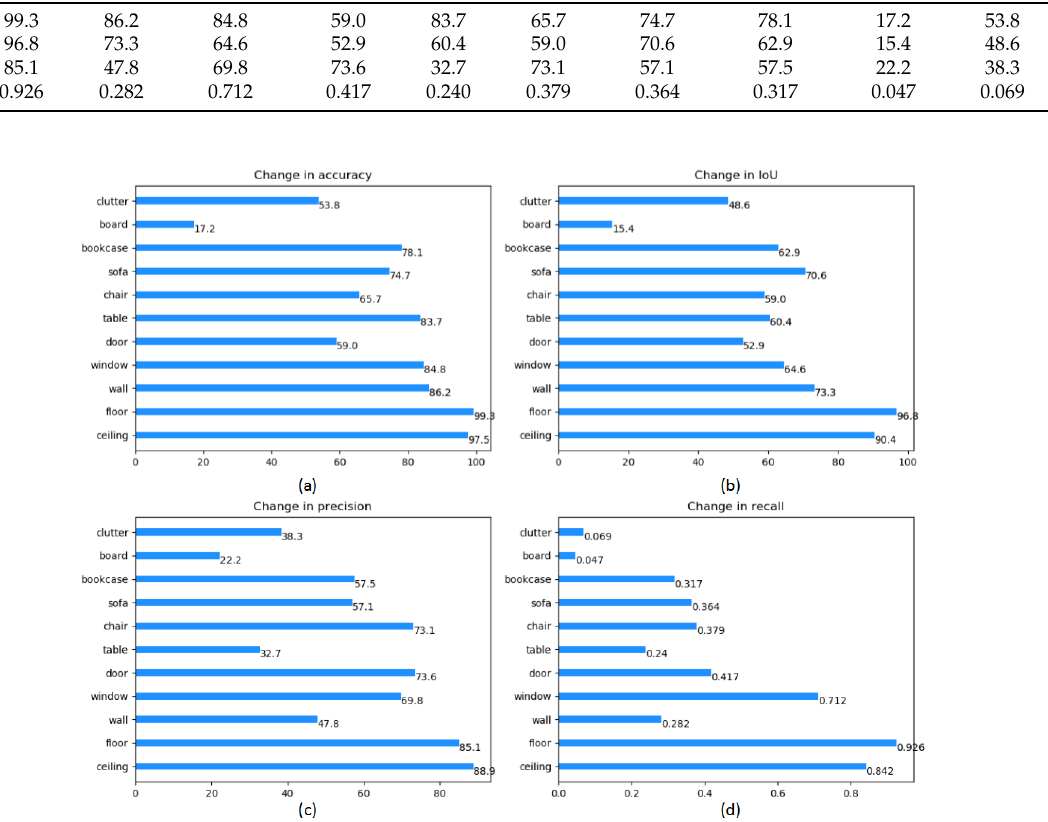
Table 4. Evaluated the change of each target of our classes on the S3DIS dataset. CA = Change in accuracy, CIoU = Change in IoU, CP = Change in precision, CR = Change in recall. Ceiling Table Chair Sofa Bookcase Board Clutter